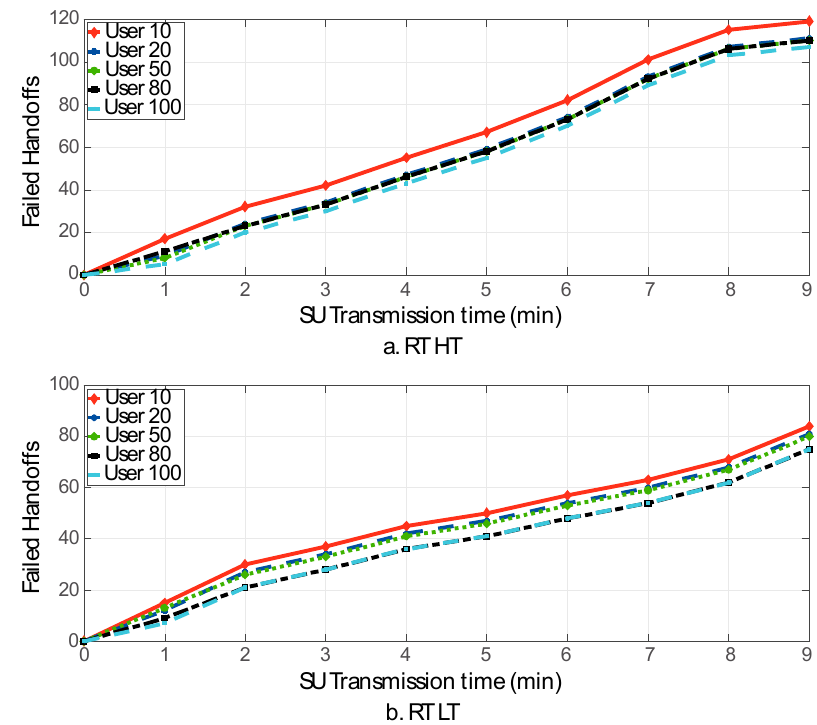
Figure 17. Failed handoffs for SAW: ( a ) Real time (RT) and high traffic (HT); ( b ) Real time (RT) and low traffic (LT).